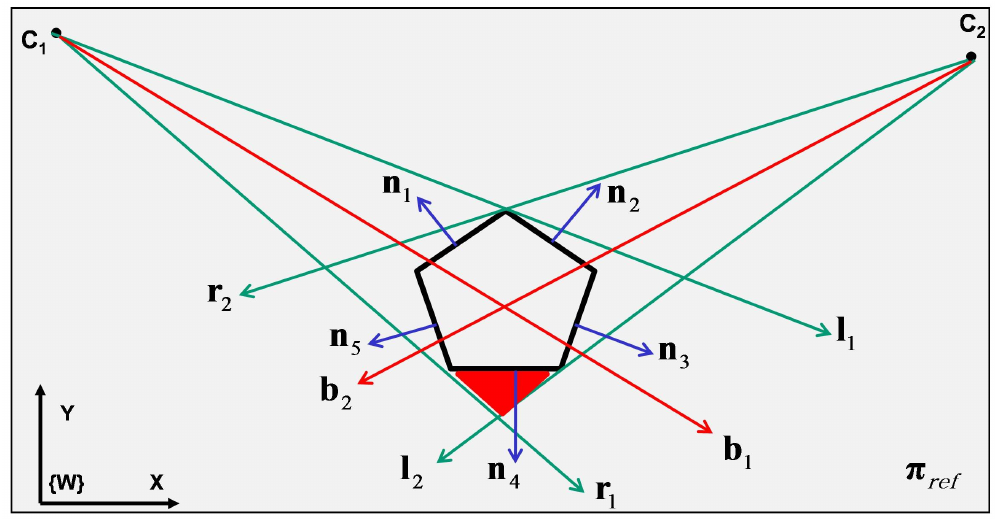
Figure 2. The figure shows the involved vectors. Green vectors, l indicate the left and right tangents (bounding vectors) of a camera c for each camera bounding pair (the tangents) of l the normal of the edge e algorithm, the area colored in red also become registered as a part of the